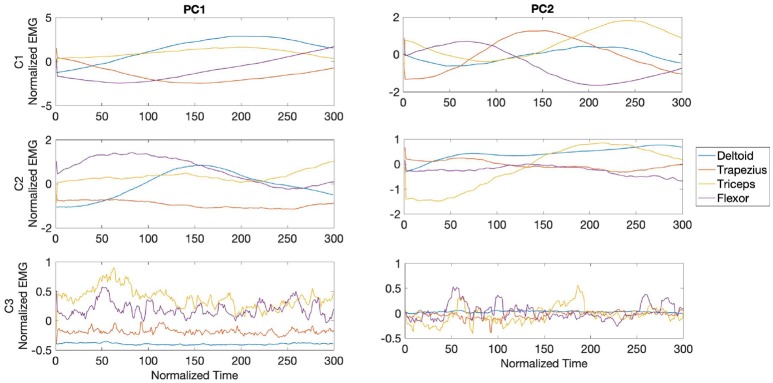
Waveforms showing the two principal components of muscle activation across the deltoid (blue), trapezius (orange), triceps (yellow), and wrist flexor (purple) muscles for cellists C1-3 in the fast phase (top panel in Figure 8). Each panel shows the activation pattern centered around bow onset (150 ms).